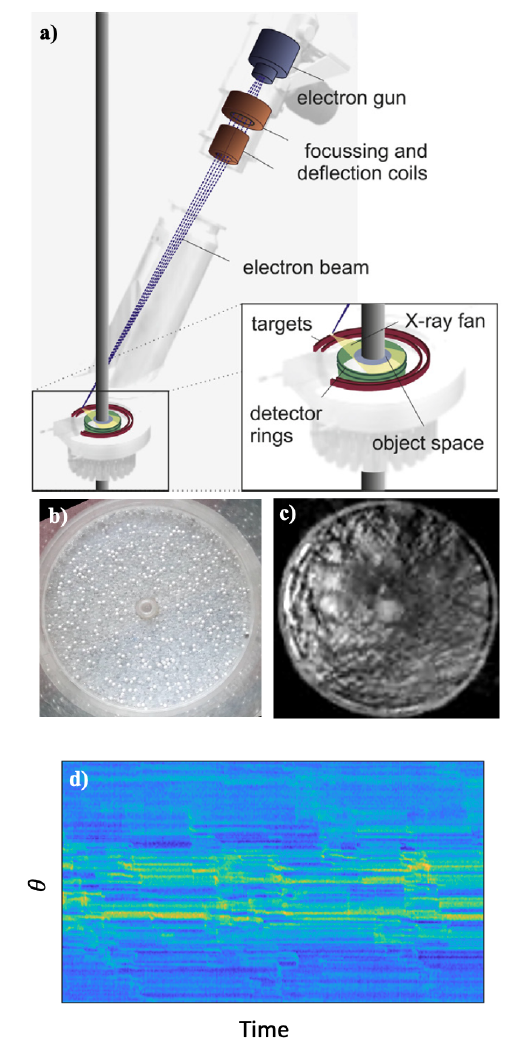
Figure 3. (a) Schematic design of the ROFEX imaging facility. Image taken from Ref. [14], (b) Optical top image of the plate- plate shear cell and (c) tomographic cut 1 mm below the upper plate, obtained during the shear experiment with the bottom plate at rest and the top plate rotating with 9 rpm ( ω = 0 . 94 s − 1 ). Inner diameter of the plate 94 mm, gap between plates 22 mm, (d) Kymograph of the 2D